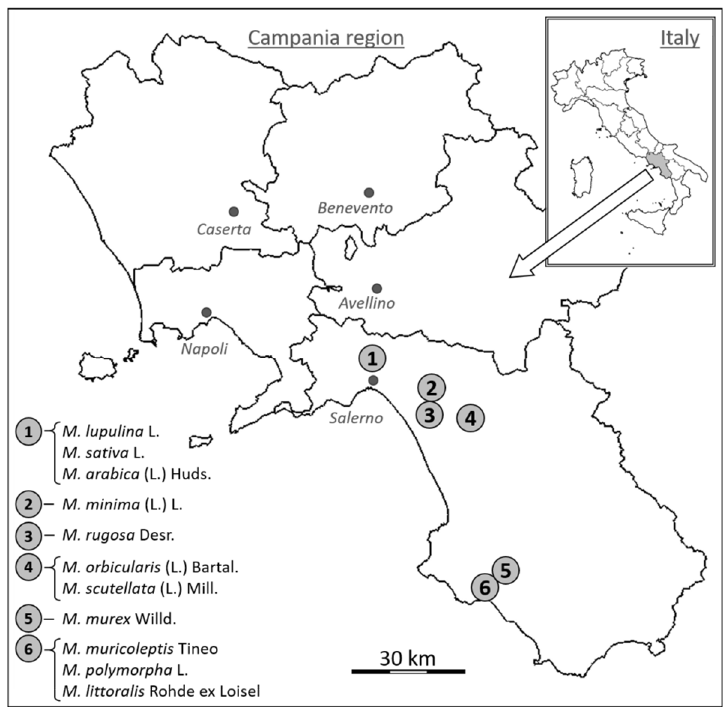
Figure 1. Map of Campania region, in southern Italy, showing the locations of the six collection sites of the eleven Medicago species investigated.